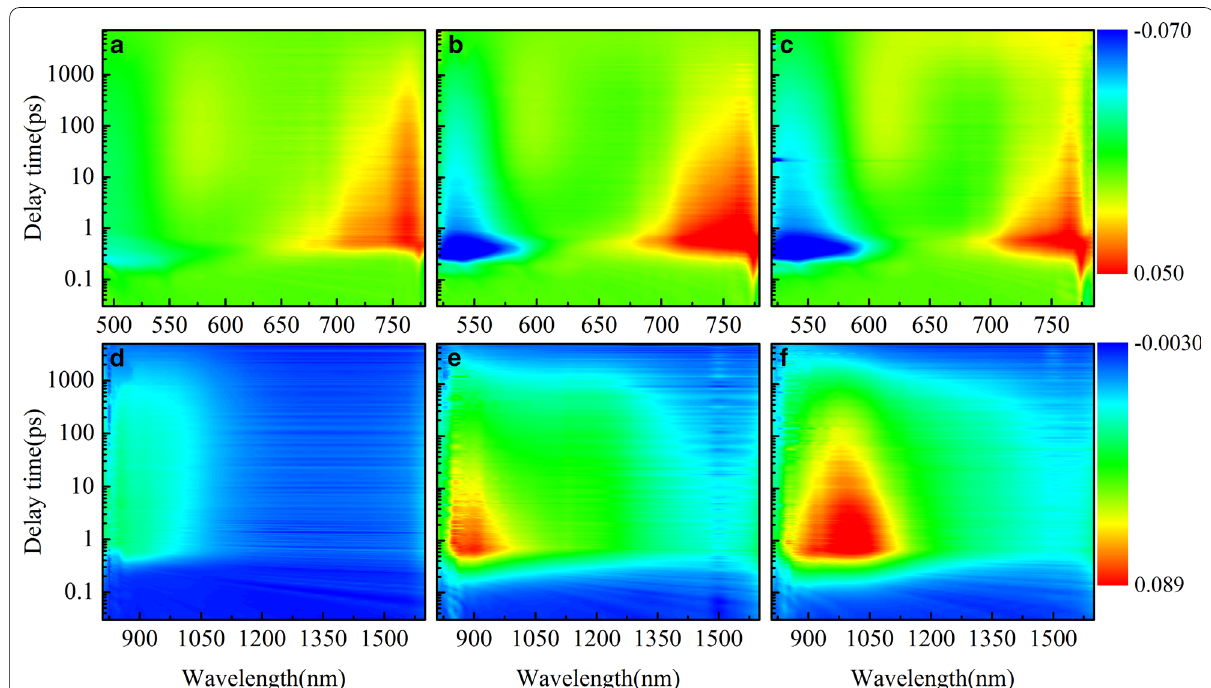
Fig. 3 Femtosecond time-resolved transient absorption (TA) spectra at different probe wavelength of different samples. Two-dimensional maps as a function of the probe wavelength (500–1600 nm) on excitation at 470 nm wavelength of the HSD-A ( a , d ); excitation at 500 nm wavelength of the HSD-B ( b , e ); excitation at 500 nm wavelength of the HSD-C ( c , f